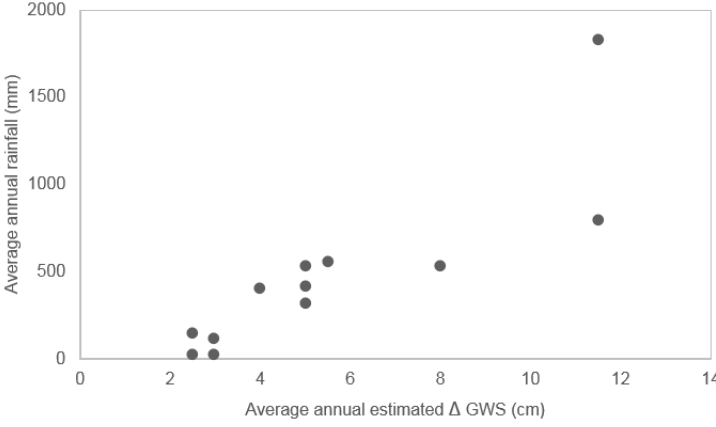
Figure 8. Comparison of average annual rainfall to the average annual GWS estimated from GRACE and LSMs products for each basin.